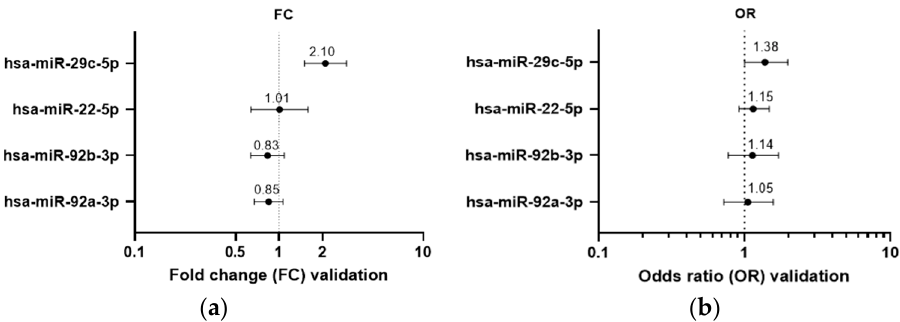
Figure 2. Fold change and forest plot representing the results of linear and logistic regression analysis with the four candidate differentially expressed human mature miRNAs in the validation cohort. ( a ) Fold miRNA expression change (FC) in extremely high versus very low MD, based on linear regression analysis of the four miRNAs. MiR-29c-5p was upregulated in high MD-derived nipple aspirate fluid ( p = 0.029). ( b ) Odds ratios (OR) from the logistic regression analysis including each of the four human miRNAs individually. One miRNA independently predicted extremely high MD in NAF: miR-29c-5p (OR = 1.38 (95% CI 1.00–1.98); p = 0.048).